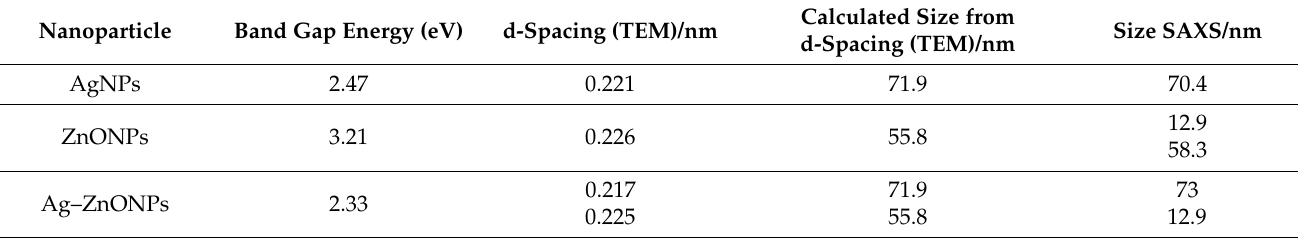
Table 1. A summary of the band gap energy, d-spacing and sizes of AgNPs, ZnONPs, and Ag– ZnONPs obtained using TEM and